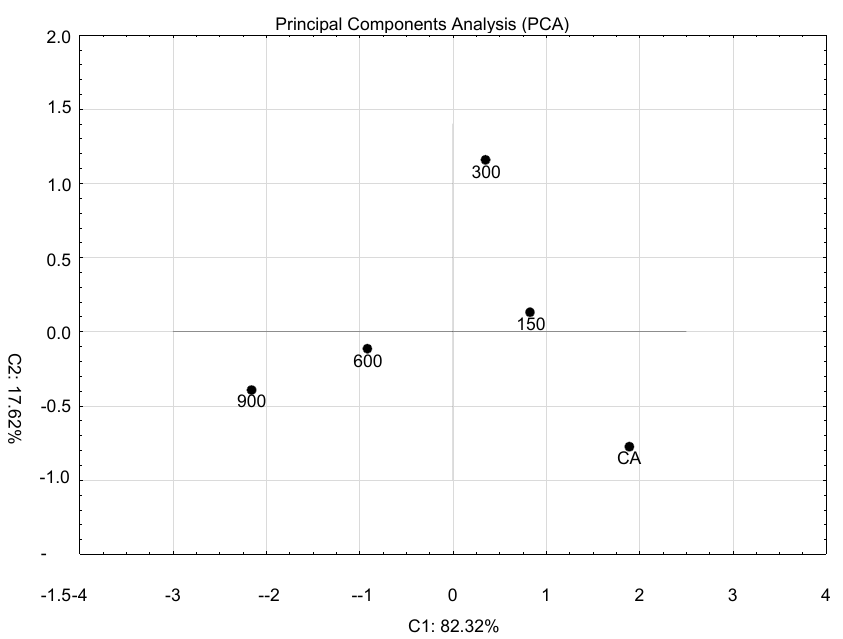
Figure 4. GGraph of principal-component analysis for larva anal Figure 4. Graph of principal-component analysis for larva anal papillae.